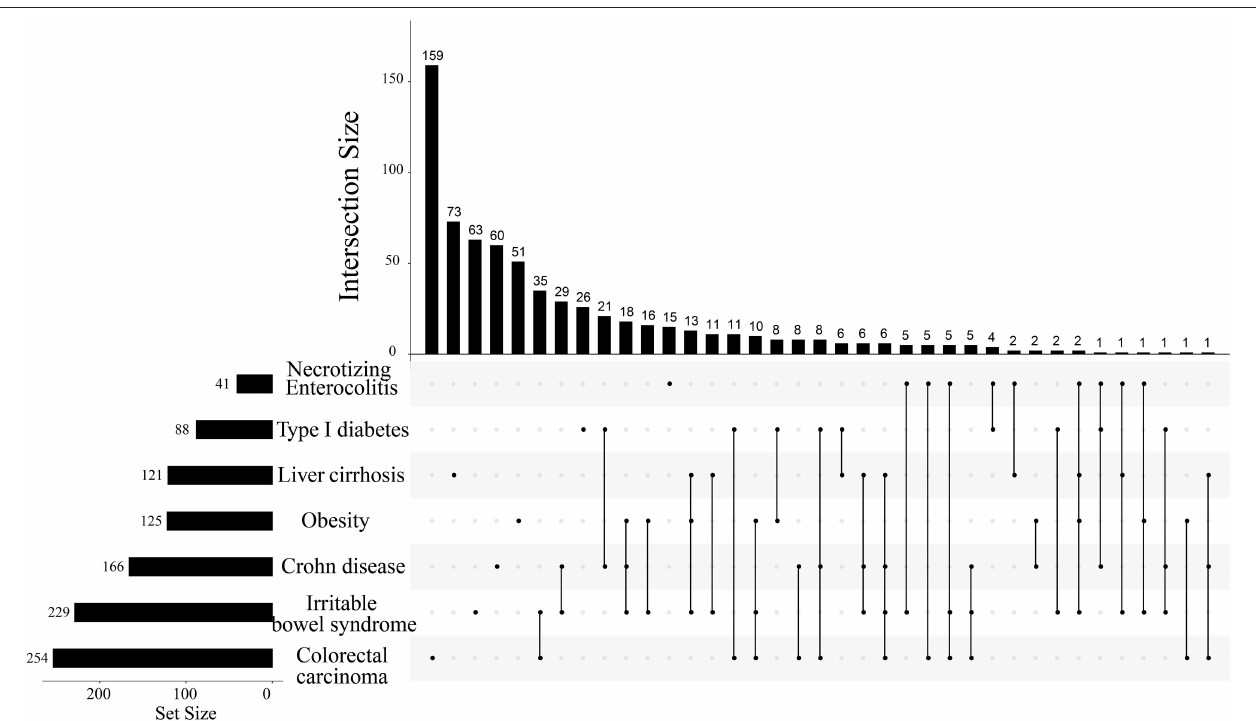
FIGURE 2 | The intersection size of natural products among 7 different diseases. The top number denotes the intersection size of diseases marked by bold folds on the line in the right lower part. For example, according to the order from left to the right, the first isolated point denotes that colorectal carcinoma has a total of 254 identified metabolites whereas it has 159 metabolites. The first line has two marked points and they meant that colorectal carcinoma and irritable bowel syndrome have 159 common metabolites beneficial to both diseases. The largest points marked on one line are four and it corresponds to the 24th line. This line means that the marked four diseases have only two common metabolites beneficial to all of